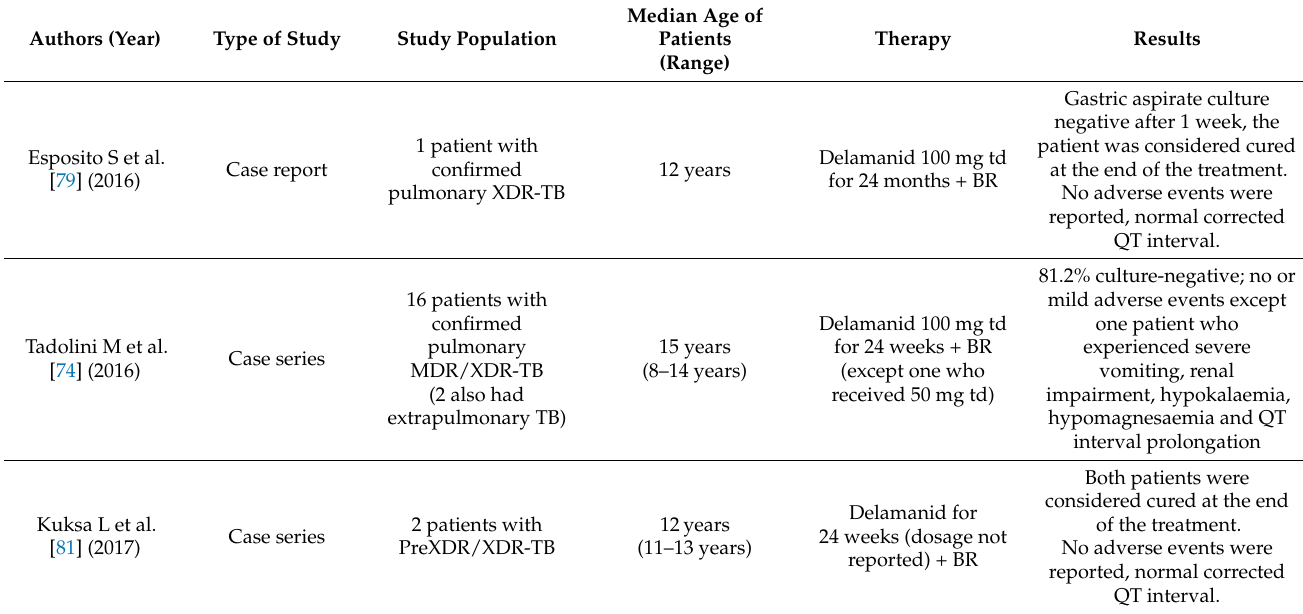
Table 7. Principal studies on delamanid in children and adolescents (0–18 years) with